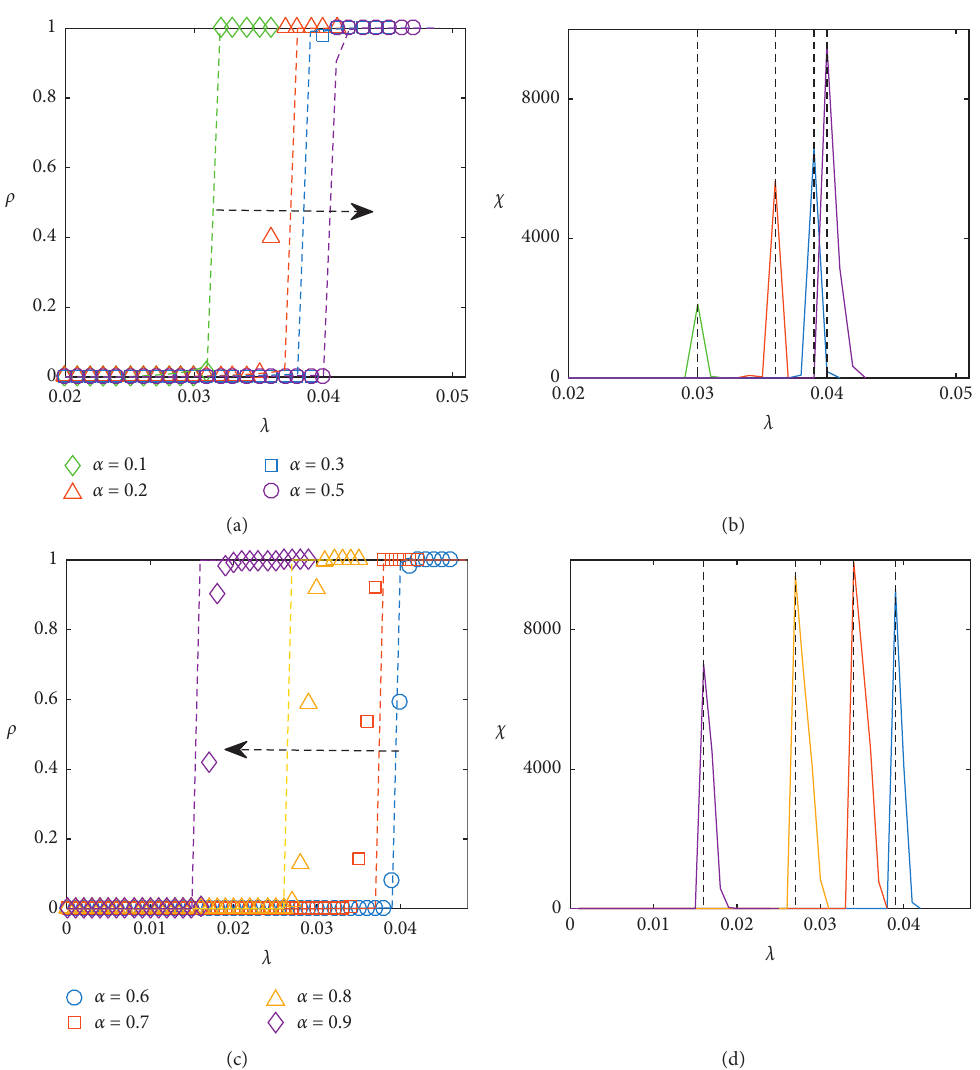
Figure 1: Effects of self-awareness on the dynamics of disease spreading on a scale-free network. (a) and (c) The prevalence ρ in the stationary state as a function of basic infection rate λ for varieties of reaction strength α . Symbols represent the results obtained from Monte Carlo simulations, and lines represent the results of the GDMP method. (b) and (d) The corresponding susceptibility measure χ as a function of λ . Data are obtained by averaging over 500 independent simulations.